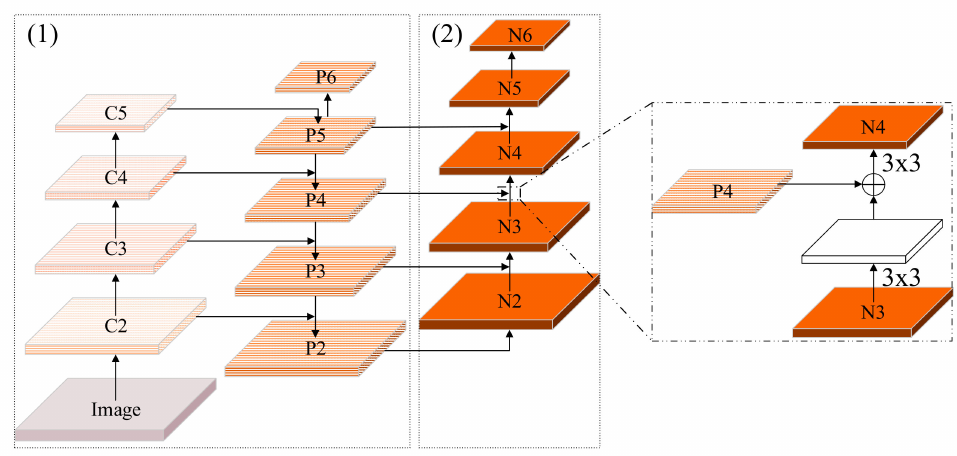
Figure 4. (1) Original structure of Mask R-CNN. (2) Path structure improved in this